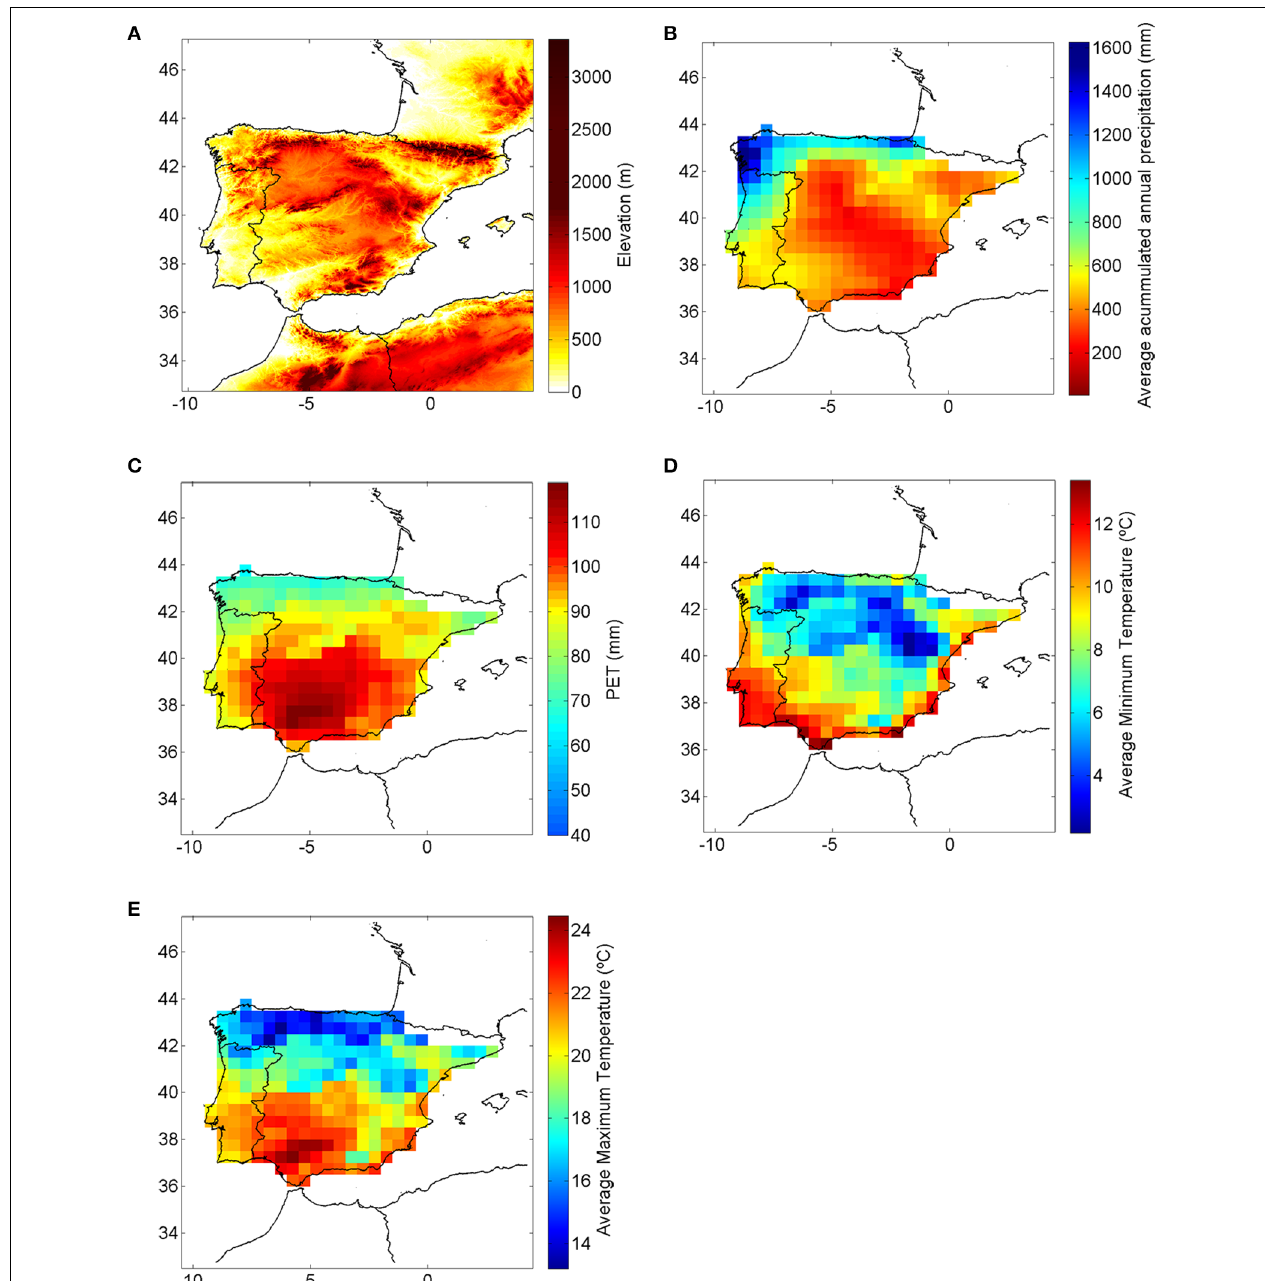
FIGURE 1 | Elevation (A), annual mean accumulated precipitation (B), annual mean PET (C) minimum (D) and maximum temperature (E) in the study